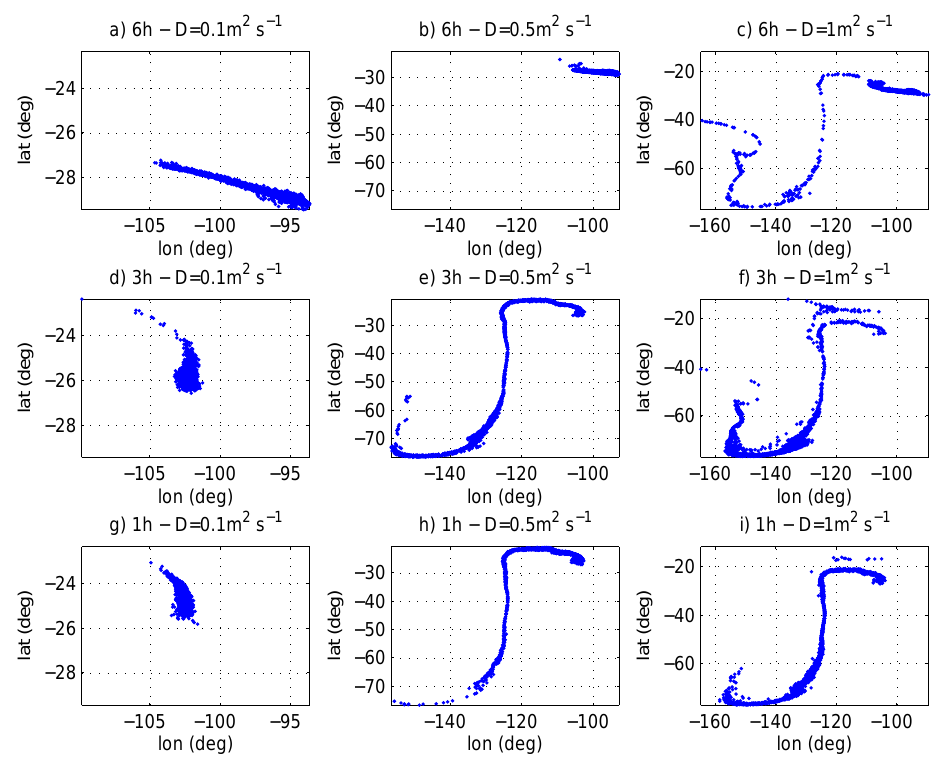
Fig. 2. Latitude-Longitude coordinates of the members of the ensemble of parcels for a sample point at 17km (corresponding to the tracer peak) along the ballon profile advected 192h of backwards. The clouds of points extend in the Southern Pacific in a neighborhood of Easter Island (27 ◦ 07 0 S, 109 ◦ 22 0 W); with a low diffusion the parcels remain confined close to the tropics, but with a higher diffussion they reach close to the polar region (Antarctica). The rows correspond to 6, 3 and 1h time intervals for the advecting winds, respectively. First column: D =0.1m 2 s − 1 . Second column: D =0.5m 2 s − 1 . Third column: D =1m 2 s − 1 .